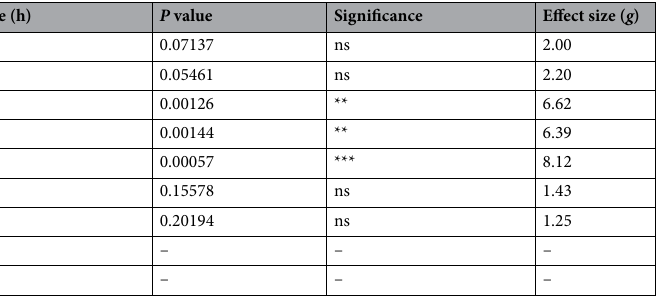
Table 3. Difference in cell survival between 0.5 nL and 0.2 nL drops. Statistical differences are presented as P values. Two-sided Student’s t test was used to find significance values. Effect sizes were calculated as